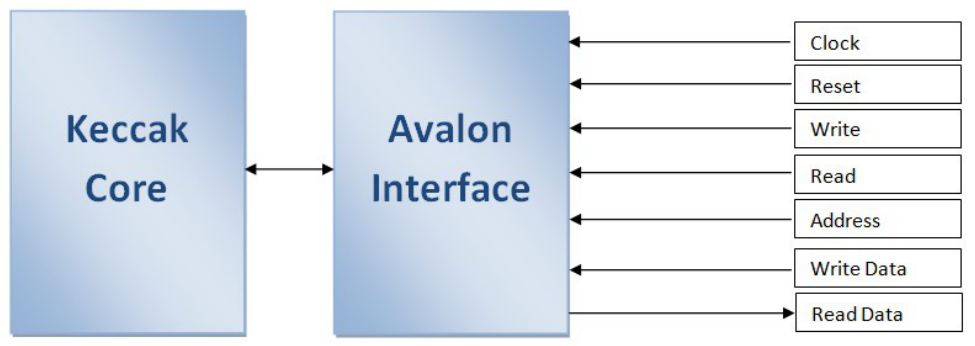
Figure 6. Data transfer between Avalon Switch Fabric and Keccak